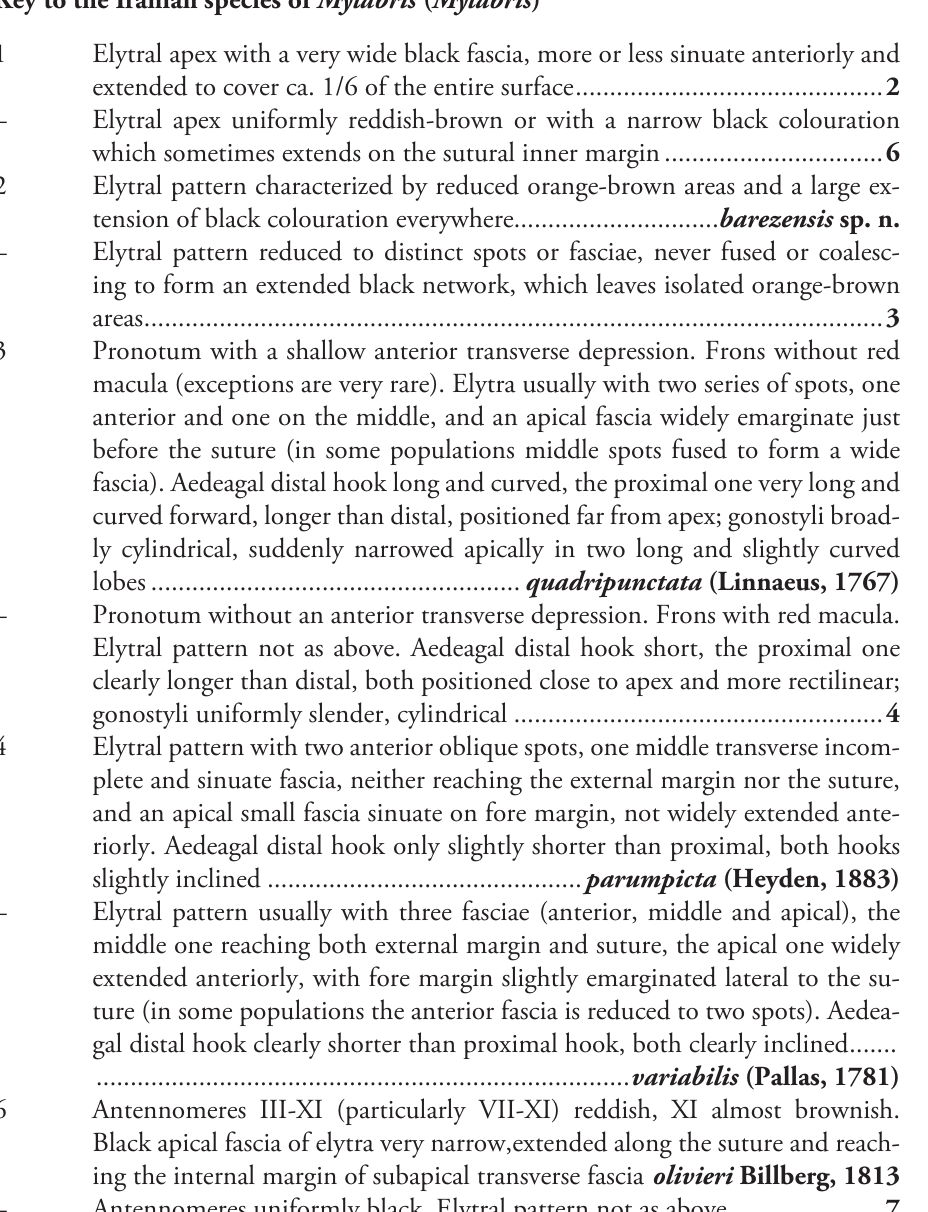
Key to the Iranian species of Mylabris ( Mylabris ) 1 Elytral apex with a very wide black fascia, more or less sinuate anteriorly and extended to cover ca. 1/6 of the entire surface ............................................. 2 – Elytral apex uniformly reddish-brown or with a narrow black colouration which sometimes extends on the sutural inner margin ................................ 6 2 Elytral pattern characterized by reduced orange-brown areas and a large ex- tension of black colouration everywhere.............................. barezensis sp. n. – Elytral pattern reduced to distinct spots or fasciae, never fused or coalesc- ing to form an extended black network, which leaves isolated orange-brown areas ............................................................................................................ 3 3 Pronotum with a shallow anterior transverse depression. Frons without red macula (exceptions are very rare). Elytra usually with two series of spots, one anterior and one on the middle, and an apical fascia widely emarginate just before the suture (in some populations middle spots fused to form a wide fascia). Aedeagal distal hook long and curved, the proximal one very long and curved forward, longer than distal, positioned far from apex; gonostyli broad- ly cylindrical, suddenly narrowed apically in two long and slightly curved lobes ...................................................... quadripunctata (Linnaeus, 1767) – Pronotum without an anterior transverse depression. Frons with red macula. Elytral pattern not as above. Aedeagal distal hook short, the proximal one clearly longer than distal, both positioned close to apex and more rectilinear; gonostyli uniformly slender, cylindrical ...................................................... 4 4 Elytral pattern with two anterior oblique spots, one middle transverse incom- plete and sinuate fascia, neither reaching the external margin nor the suture, and an apical small fascia sinuate on fore margin, not widely extended ante- riorly. Aedeagal distal hook only slightly shorter than proximal, both hooks slightly inclined .............................................. parumpicta (Heyden, 1883) – Elytral pattern usually with three fasciae (anterior, middle and apical), the middle one reaching both external margin and suture, the apical one widely extended anteriorly, with fore margin slightly emarginated lateral to the su- ture (in some populations the anterior fascia is reduced to two spots). Aedea- gal distal hook clearly shorter than proximal hook, both clearly inclined ....... 6 Antennomeres III-XI (particularly VII-XI) reddish, XI almost brownish. Black apical fascia of elytra very narrow,extended along the suture and reach- ing the internal margin of subapical transverse fascia olivieri Billberg, 1813 – Antennomeres uniformly black. Elytral pattern not as above ...................... 7 7 Elytra uniformly reddish-brown with an extremely narrow black fascia on the